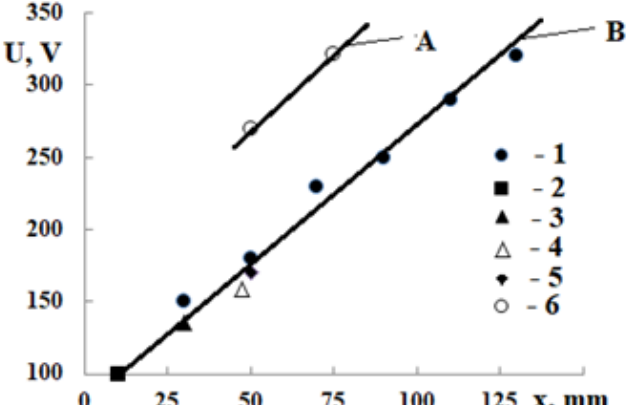
Figure 4. Dependence of arc voltage on its length. Arc current (A): 1—160, 2 and 3—150, 4—200, 5 and 6—180. Line A—plasma torch operates with waste, B—without waste. Air inlet flow rate: plasma torch—1 g/s, protecting gas—2.63 g/s.